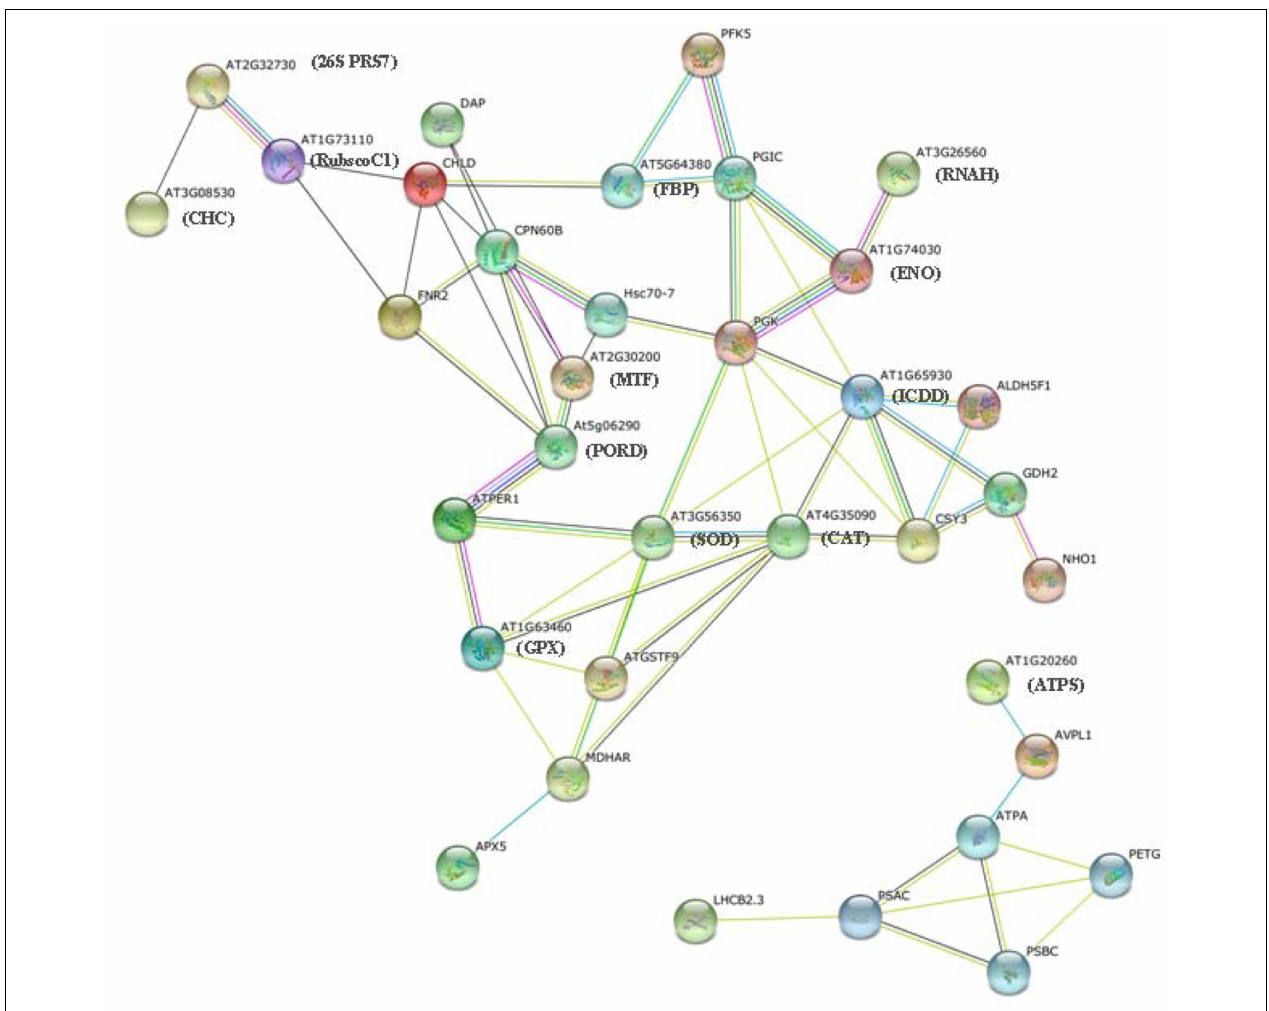
FIGURE 6 | Protein–protein interaction network analysis of salinity stress-responsive proteins. The data categorized in A and B show two independent groups of interaction